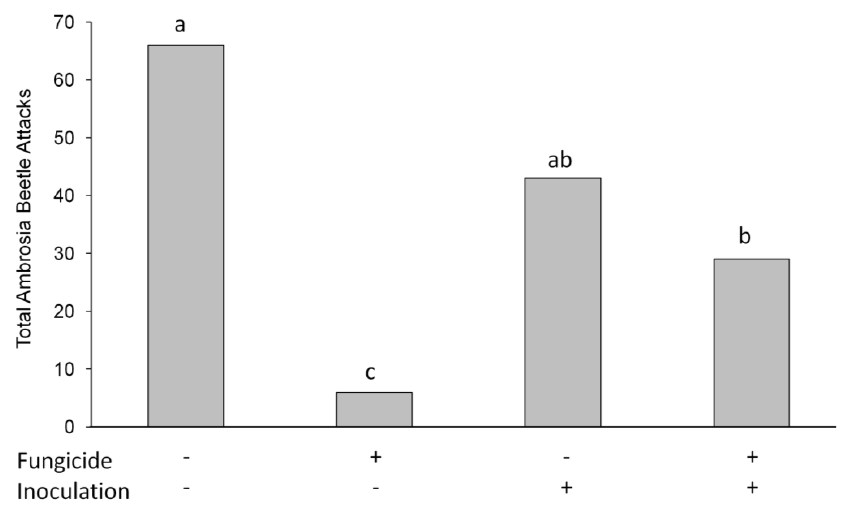
Figure 2. Total ambrosia beetle attacks on flooded redbud and tulip poplar trees (tree species data were combined due to no statistical difference detected). Data also represent combined Trial 1 and 2 data due to low ambrosia beetle incidence in trials. Fungicide+ = plants treated with Pageant ® Intrinsic ® ; Inoculation+ = plants inoculated with P. cinnamomi . Bars with different letters are significant at p < 0.05 by Scheffe pair-wise comparison.